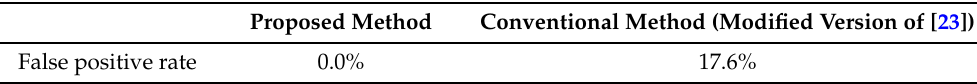
Table 2. False-positive rate for nonobstacle datasets (change in floor